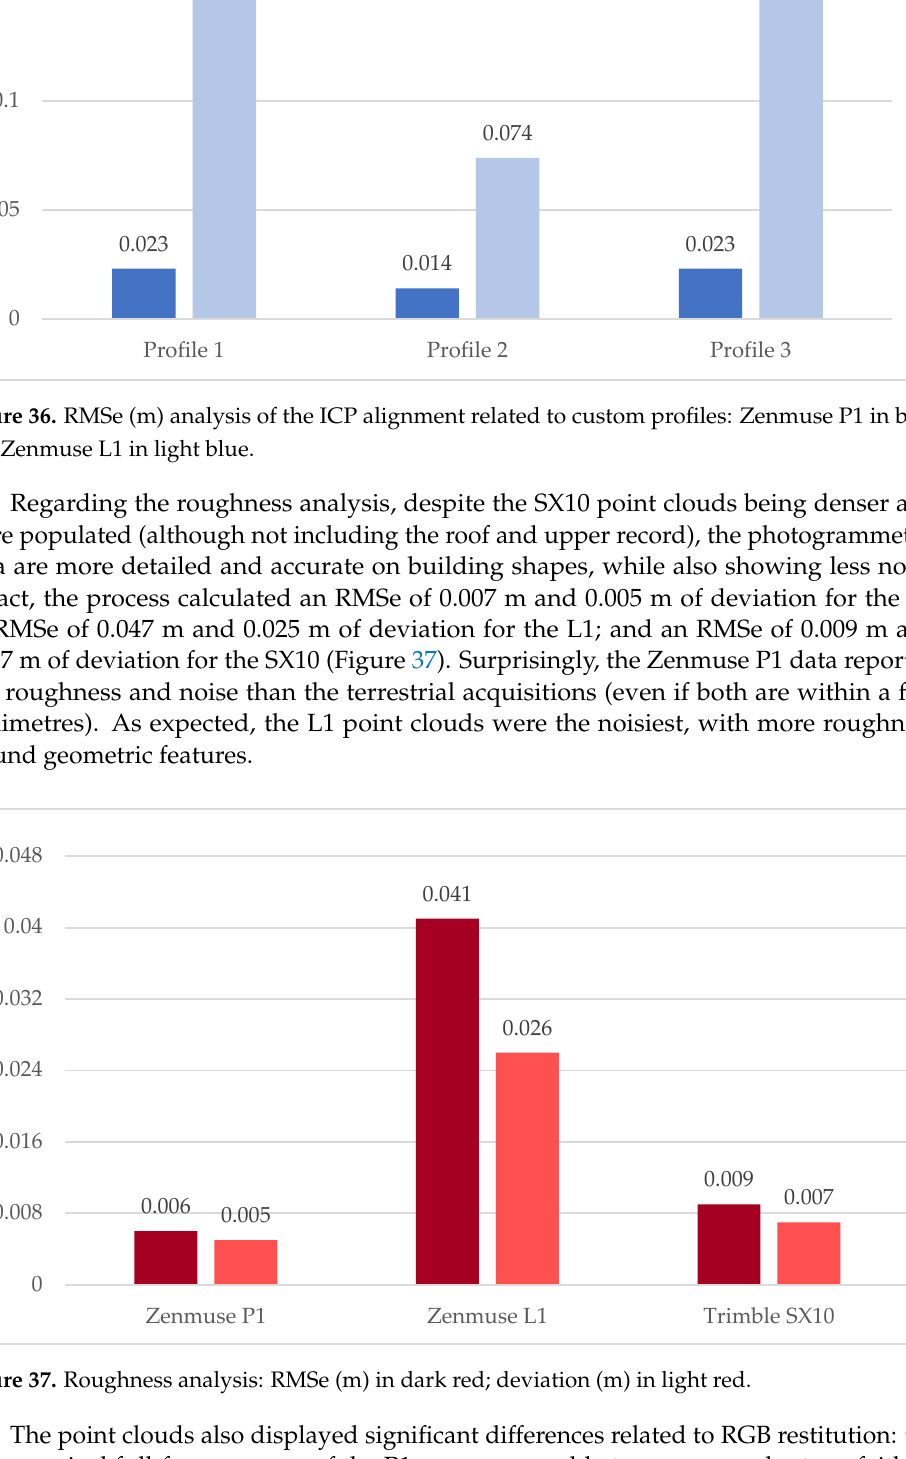
alignment generated satisfying results. The photogrammetric data show centimetric RMS errors (between 0.014 m and 0.023 m) in all analysed profiles, while L1 data reported an average RMS error of 13 centimetres (Figure 36): the higher value is 0.164 m, and the lower one is 0.074. The alignment of the photogrammetric output to the SX10 data was revealed ground plan.